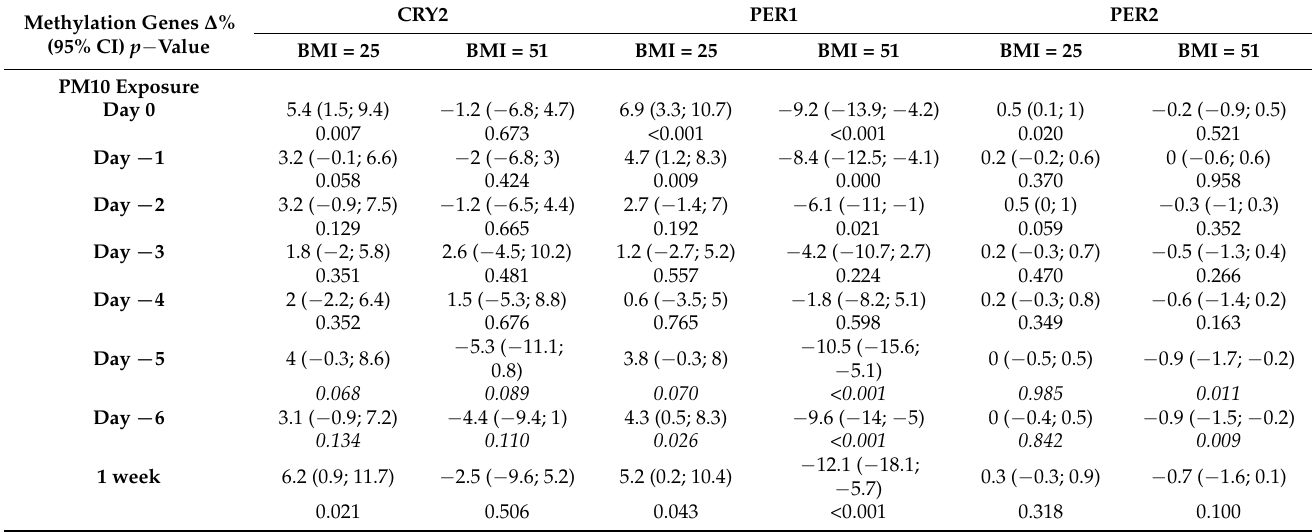
Table 5. Association between PM 10 exposure and the methylation of the CRY2 , PER1 , and PER2 genes for selected BMI values. Significant associations ( p -value < 0.05) are highlighted in bold characters.